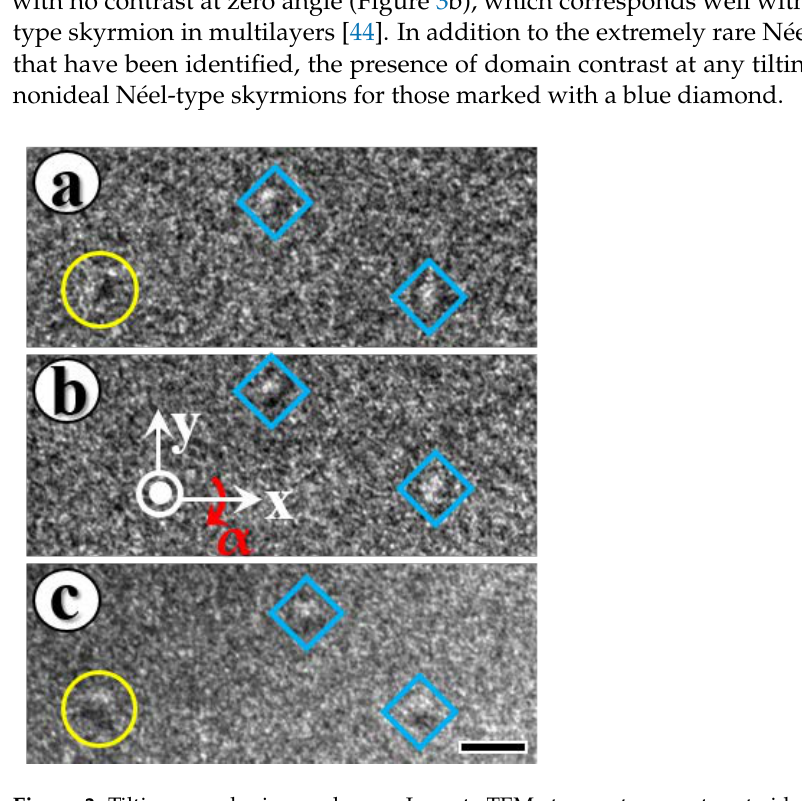
Figure 3. Tilting samples in a real-space Lorentz TEM at room temperature to identify skyrmion type. The tilt angle α around x axis is ( a ) − 18°, ( b ) 0° and ( c ) 18°, respectively. Based on the disappearance of contrast at 0° tilt and reversed contrast for opposite tilt angles, the skyrmion in the yellow circle is identified as Néel-type. The skyrmions marked with blue diamond indicate nonideal Néel-type skyrmions based on the presence of domain contrast at any tilt angle. The scale bar in ( c ) is 200 nm. Micromagnetic simulations were used to figure out the nonideal N é el-type skyrmion configuration. Micromagnetic simulations across a 0.6 × 0.6 µ m 2 area discretized into 2 × 2 × 2 nm 3 cells are performed using Mumax3 software [43] based on the Landau– Lifshitz–Gilbert equation with a relax function to find the minimum energy of the